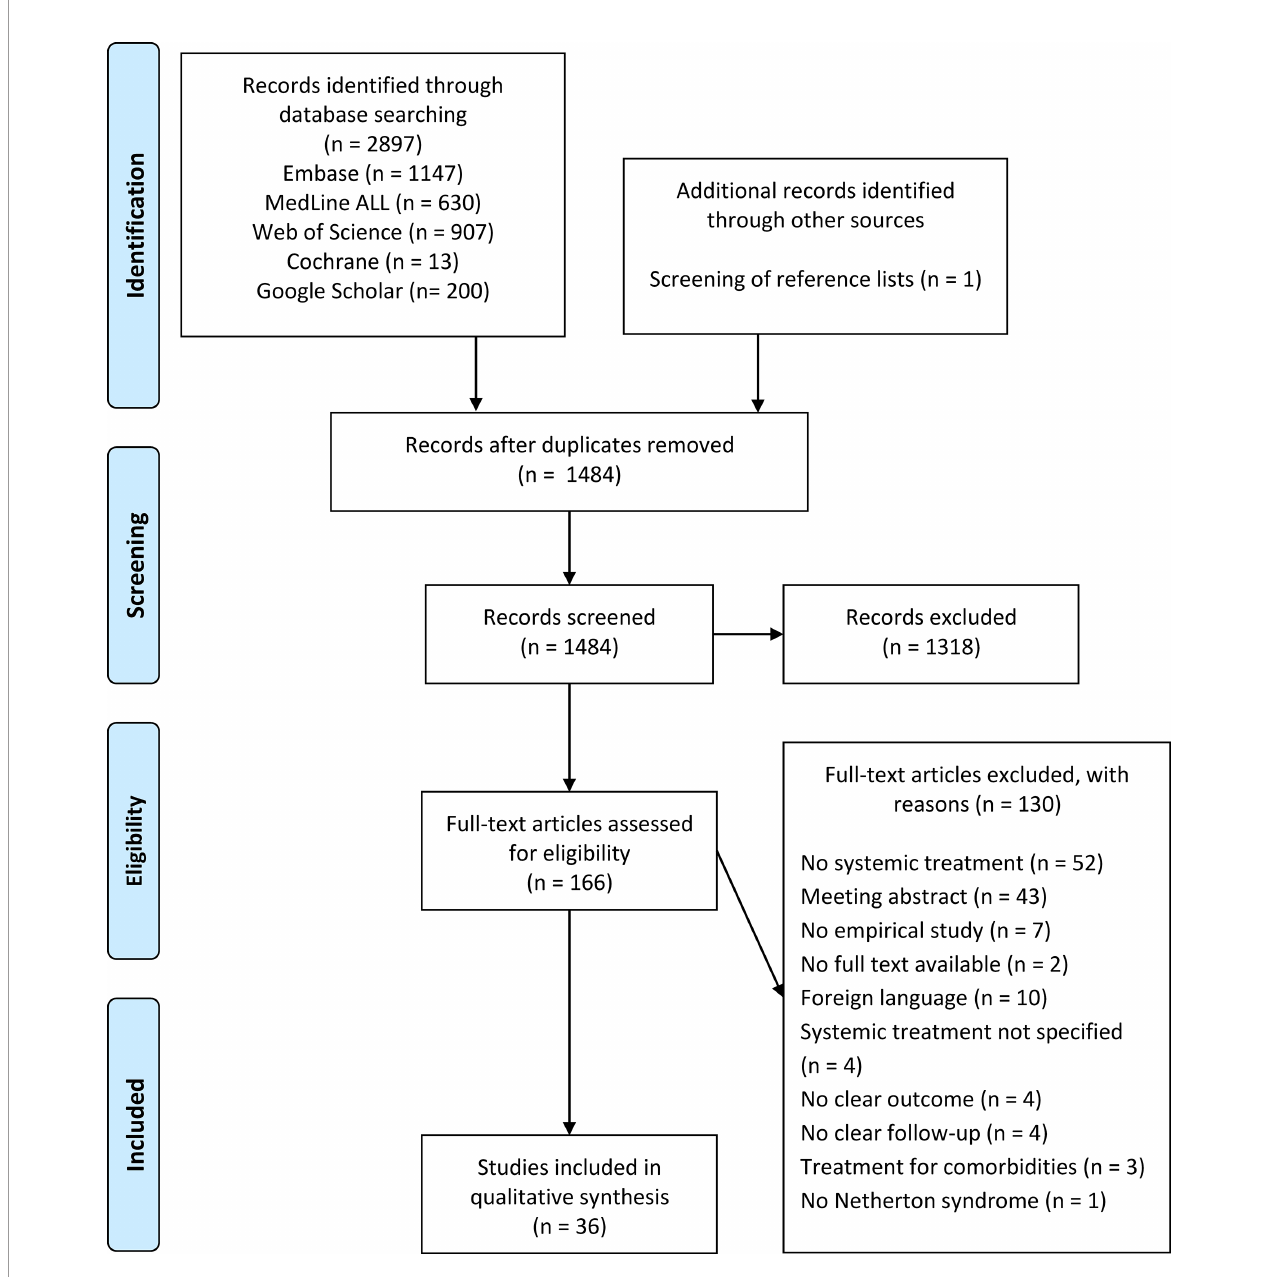
FIGURE 1 | Flowchart of the article